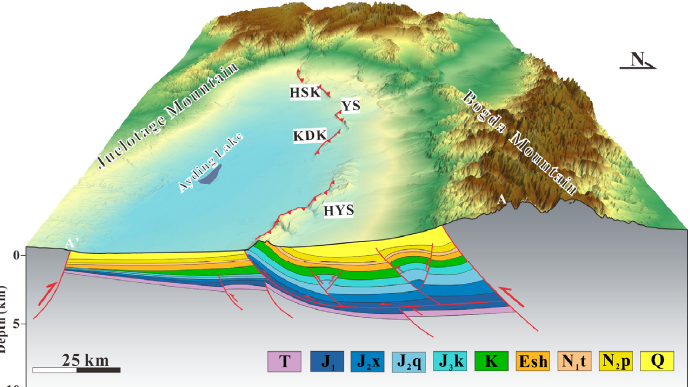
Figure 2. ( a ) Topography of the Huoyanshan structure (location in Figure 1c), lines 1–3 are seismic lines. ( b ) Simplified geologic map (modified from Peng) [56], location in ( a ). ( c ) Strike profile of the Huoyanshan anticline (location of B–B ′ in ( b )).